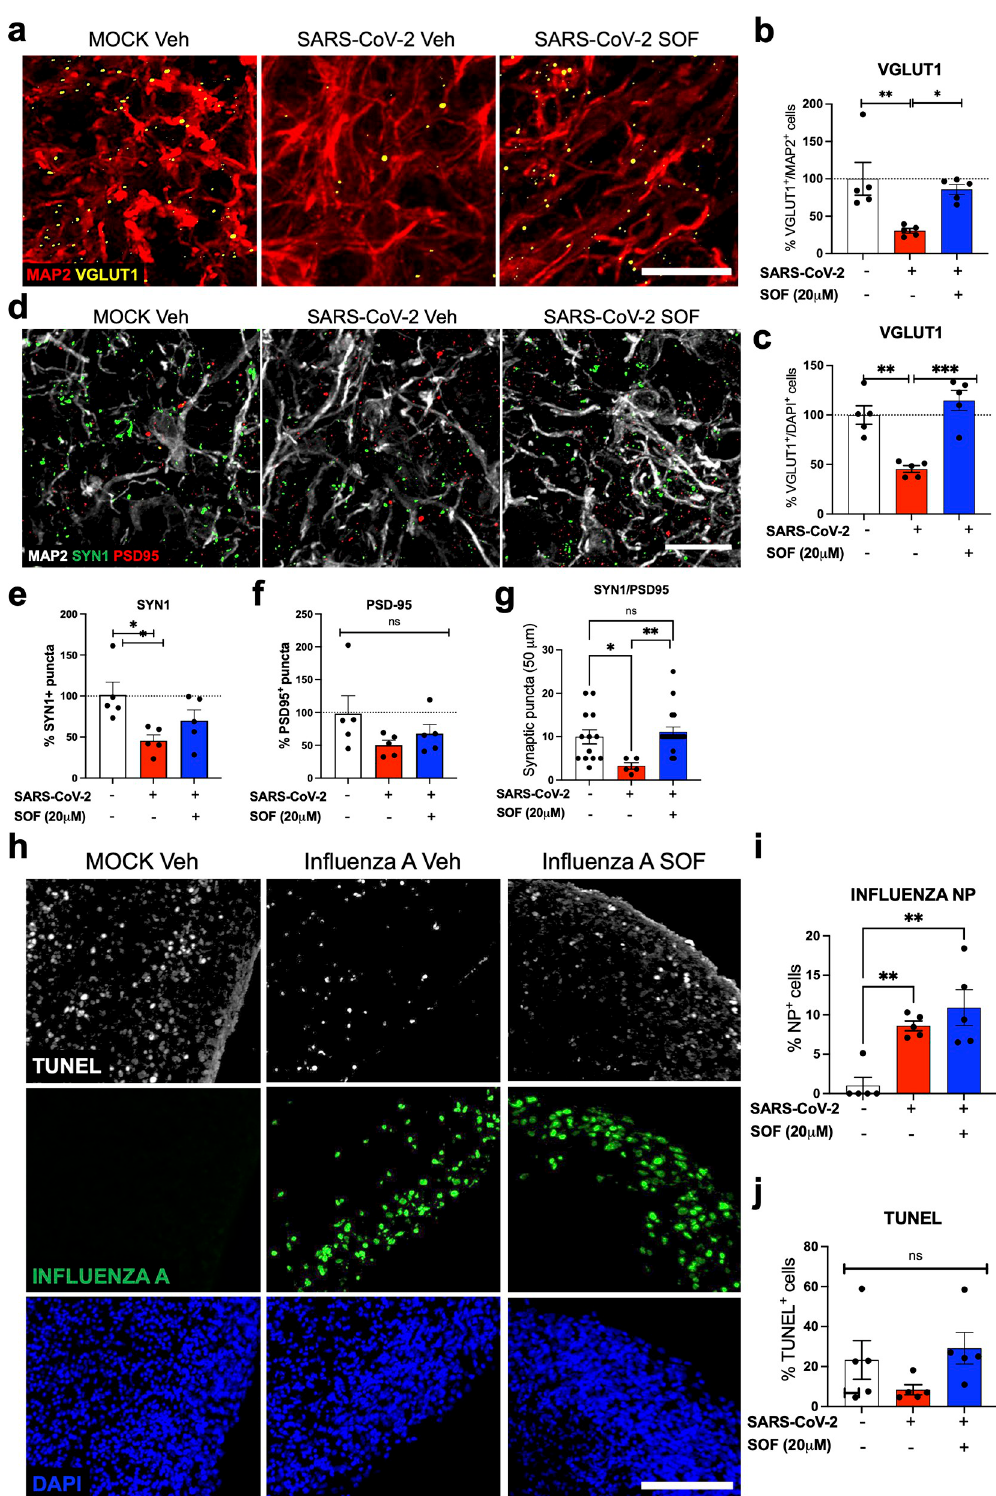
Fig 3. SARS-CoV-2 decreases excitatory synapses in BCO. a,b,c. Immunolabeling and quantification of vGLUT1 positive cells (yellow) within MAP2 + neurons (red) or compared to overall cells in BCO infected at MOI 2.5 and treated with vehicle (Veh) or 20 μ M Sofosbuvir (SOF) n = 5 biological replicates per condition, calculated in % compared to mock conditions. Bars represent mean. Error bars represent SEM. � p < 0.05, �� p < 0.01. Significance was assessed by one-way ANOVA and Tukey’s multiple comparisons test. Scale bar, 20 μ m. d, e, f. Immunolabeling and quantification of Synapsin 1- (SYN1)